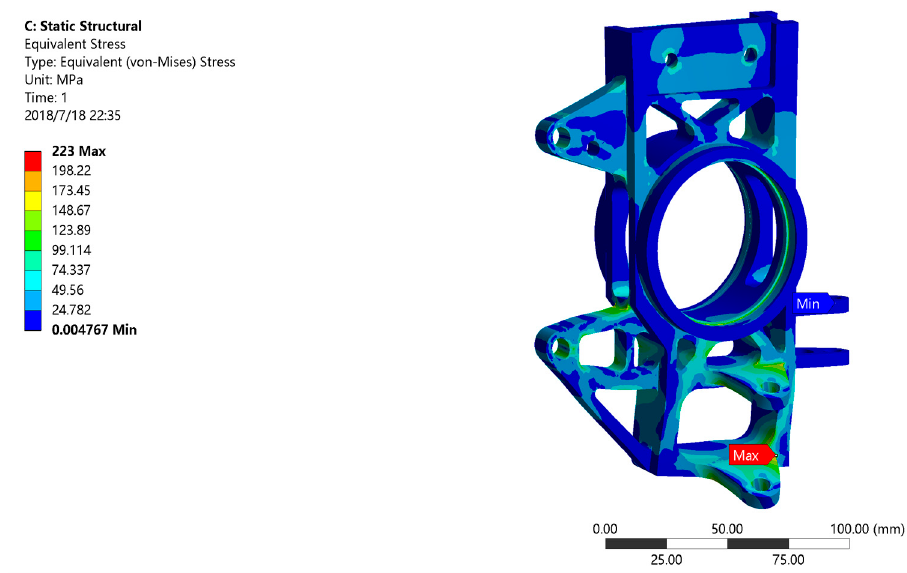
Figure 15. Stress cloud. Figure 15. Stress contour.